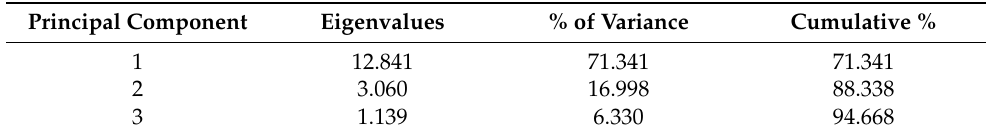
Table 4. Eigenvalues and squared loading of the principal components.